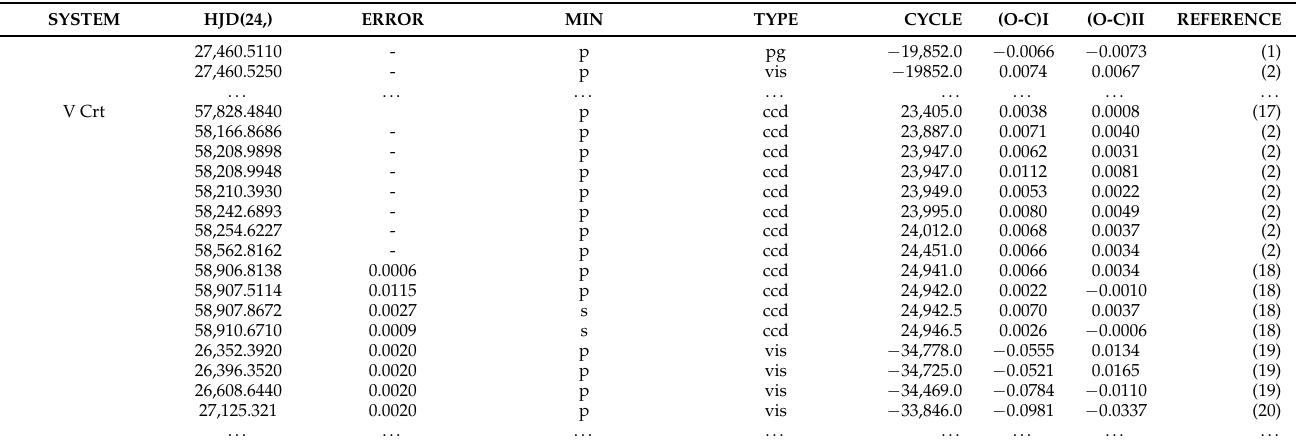
Table 4. Minimum times and relevant parameters of period variation of V Crt, WY Cnc and CG Cyg. SYSTEM